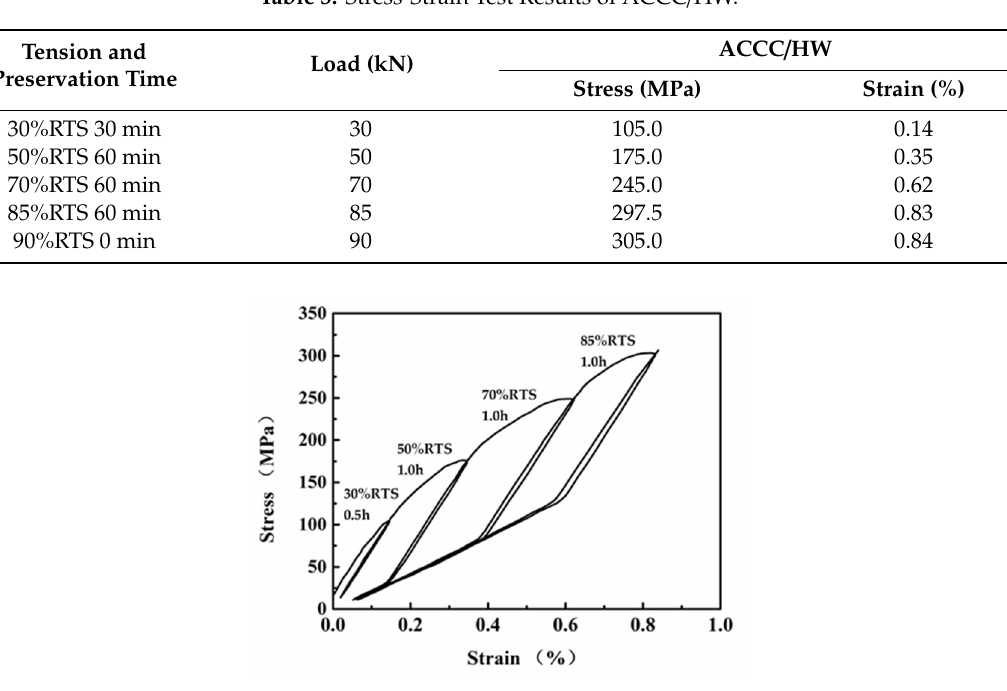
Table 3. Stress-Strain Test Results of ACCC / HW.